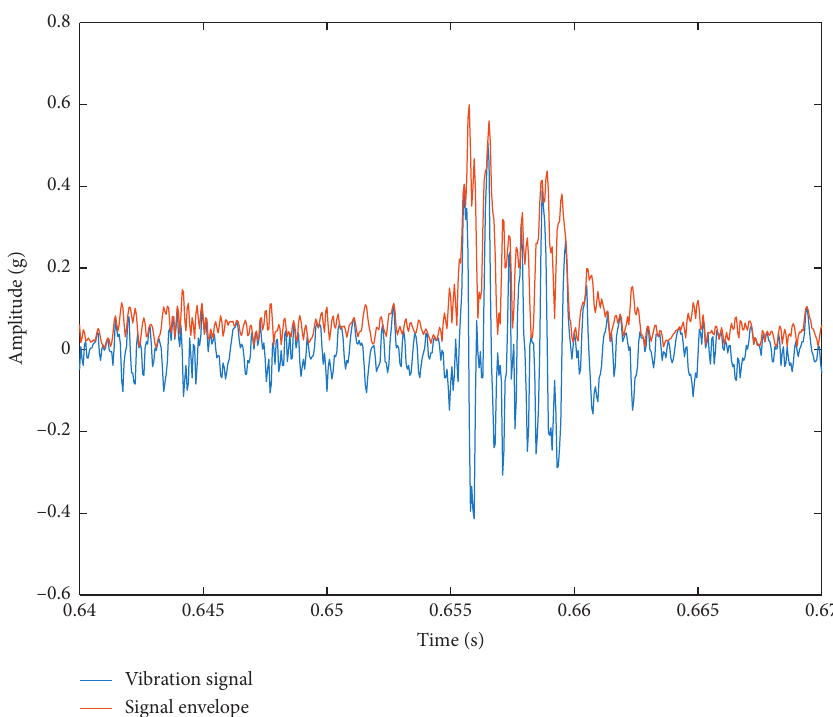
Figure 2: Dual-peak characteristics in fault bearing vibration signal.